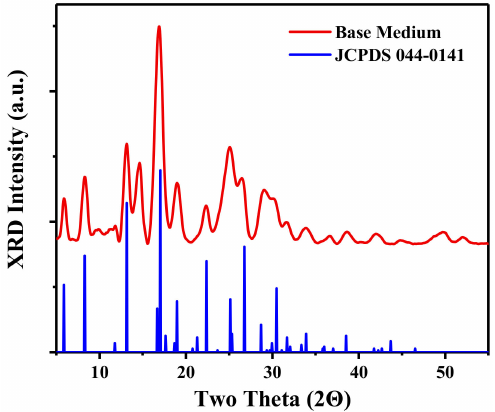
Figure 1. XRD pattern for the produced α -MnO 2